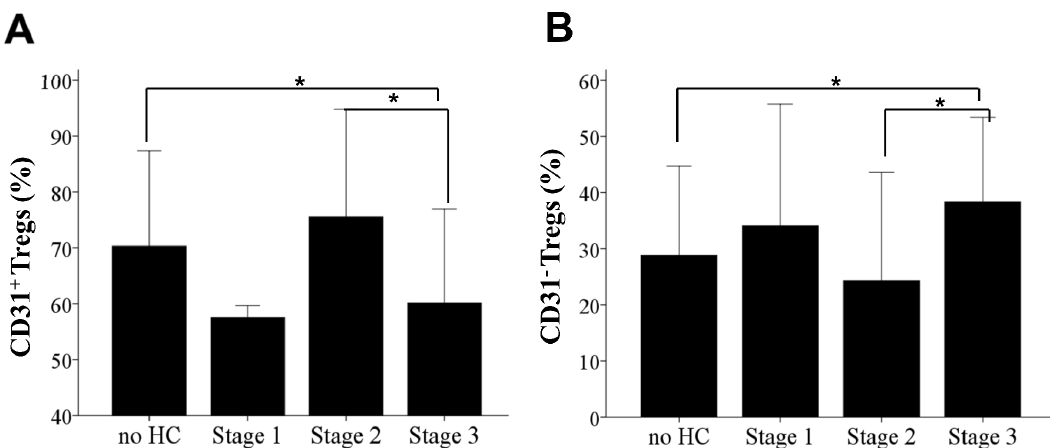
Figure 6. Histological Chorioamnionitis and Tregs Homeostasis. ( A ) Column bar graph representing means and standard deviations of CD31 + Treg percentage in CB with different staging of histological chorioamnionitis and no chorioamnionitis. Statistical significance between all groups (p=0.018) was determined by one way ANOVA with Bonferroni post hoc test. ( B ) Column bar graph representing means and standard deviations of CD31 2 Treg percentage in CB with different staging of histological chorioamnionitis and no chorioamnionitis. Statistical significance between groups (p=0.013) was determined by one way ANOVA with Bonferroni post hoc test.